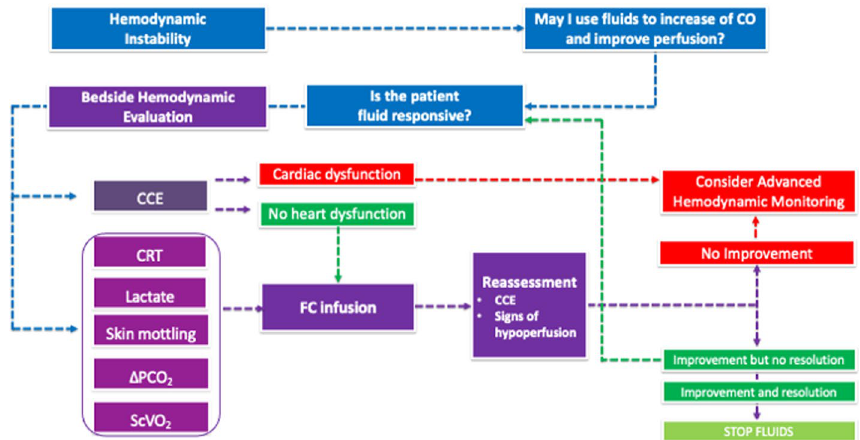
Fig. 1 Decision‑making process at the bedside to guide and titrate fluid administration during an episode of acute circulatory failure. CCE critical care echocardiography, CO cardiac output, CRT capillary refill time, FC fluid challenge, ΔPCO 2 venous‑to‑arterial CO 2 tension difference, ScVO 2 central venous oxygen